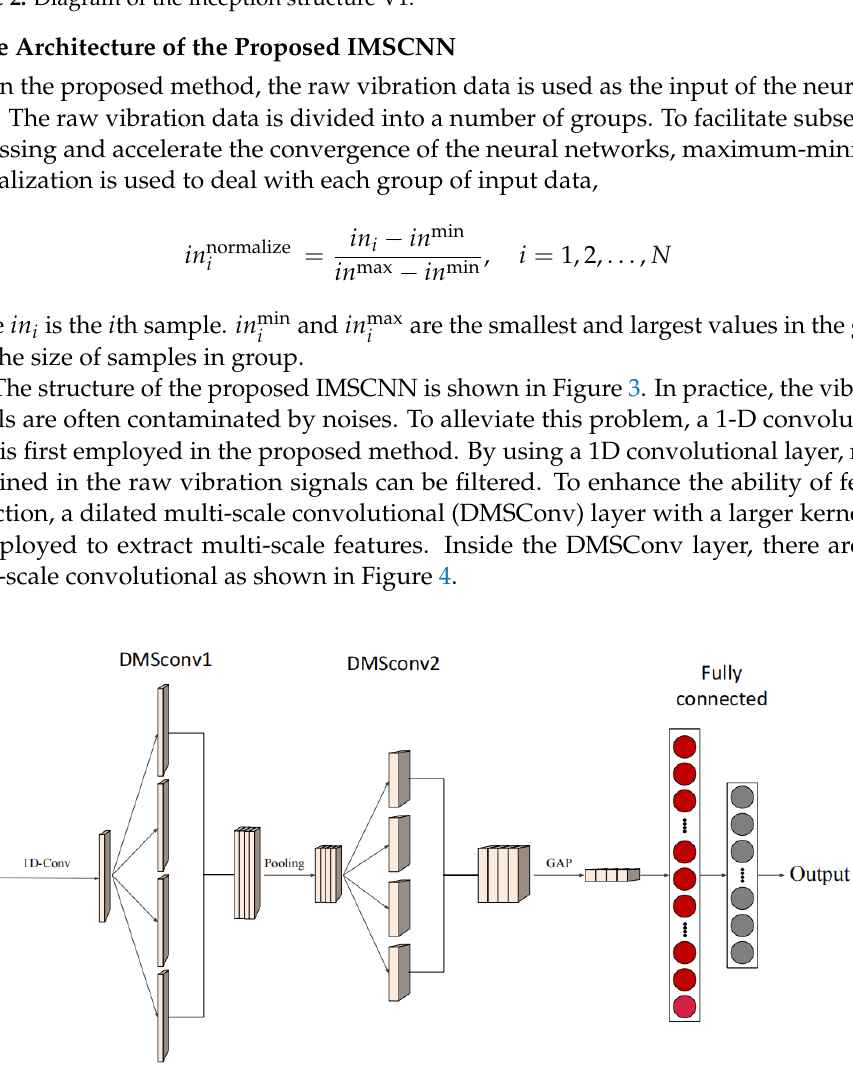
Figure 2. Diagram of the inception structure V1.